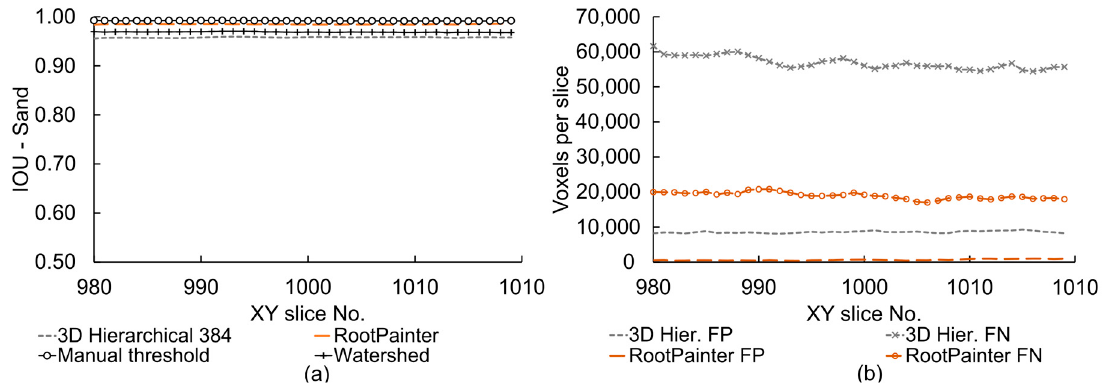
Figure 11. Comparison of mean absolute errors for ( a ) porosity and ( b ) CH 4 gas saturation estimations with mean IOU metrics for the segmentations used. W03 denotes the use of a U-Net model trained on a sub-volume of low-contrast dataset LC03; RP refers to RootPainter.